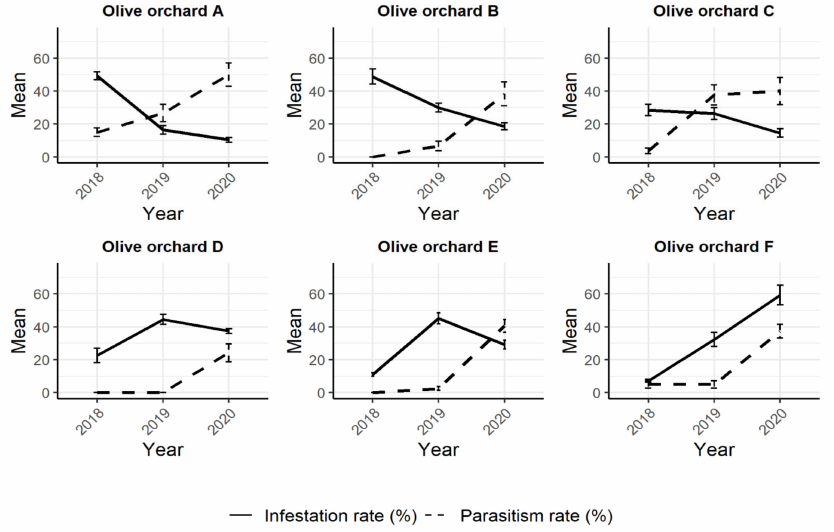
Figure 4. Parasitism rate (dashed line) and D. oleae infestation rate (full line) during 2018, 2019, and 2020 in each olive orchard. All values are means ± SEs.